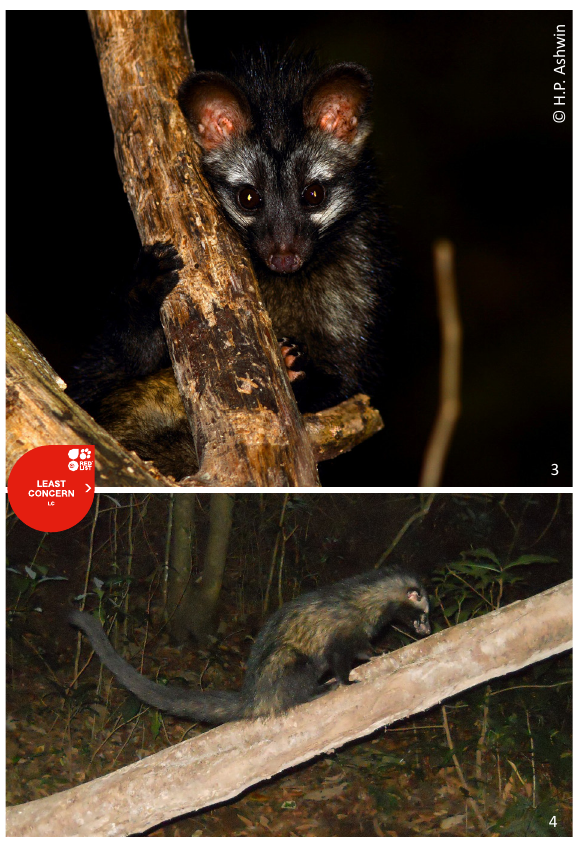
Images 3–4. Asian Palm Civet Paradoxurus hermaphroditus